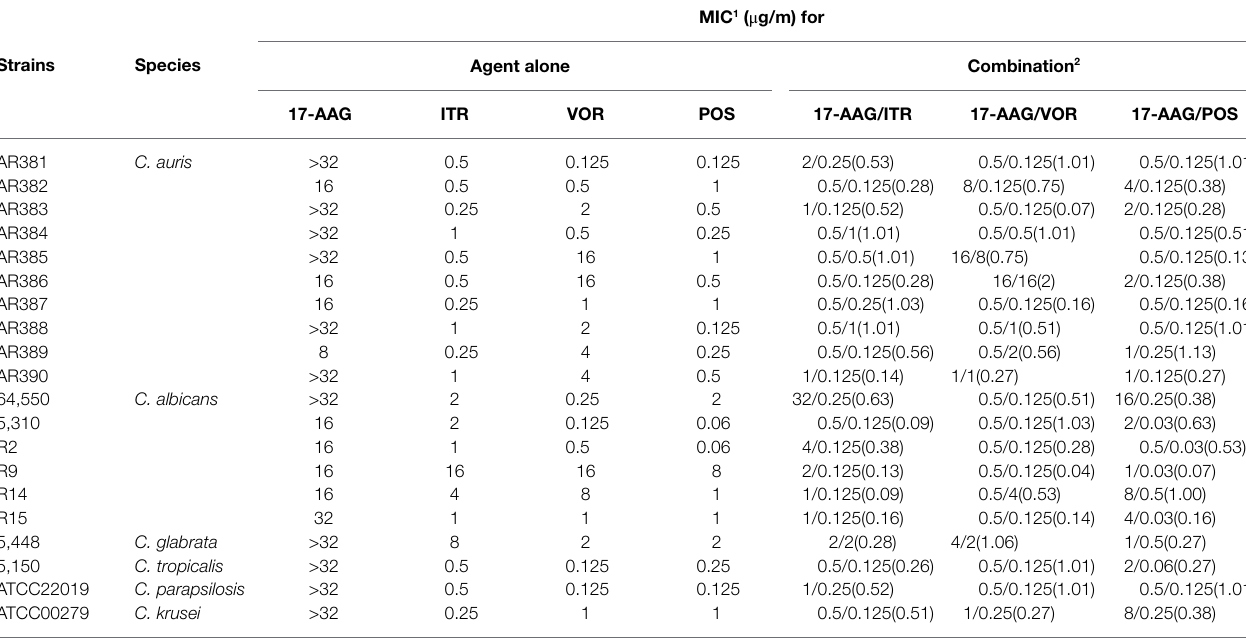
TABLE 1 | MICs and FICIs results with the combinations of 17-AAG and azoles against azole-resistant Candida spp.